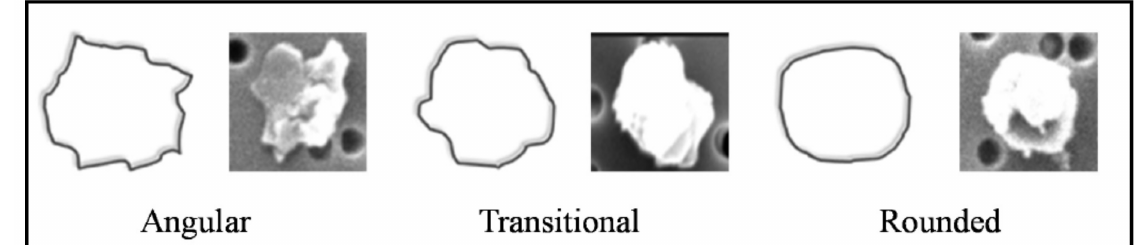
Figure 3. Angularity classification categories of SEM samples based on the qualitative analysis of the sharpness of particle edges [62].